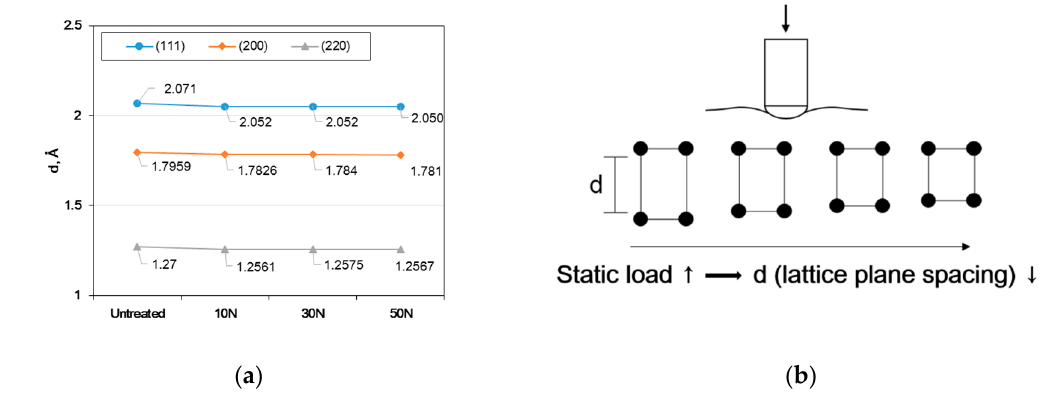
Figure 14. The effect of the static load in UNSM treatment on lattice plane spacing of Alloy 600; ( a ) measured lattice plane spacing and ( b ) decrement model of lattice plane spacing by UNSM treatment.